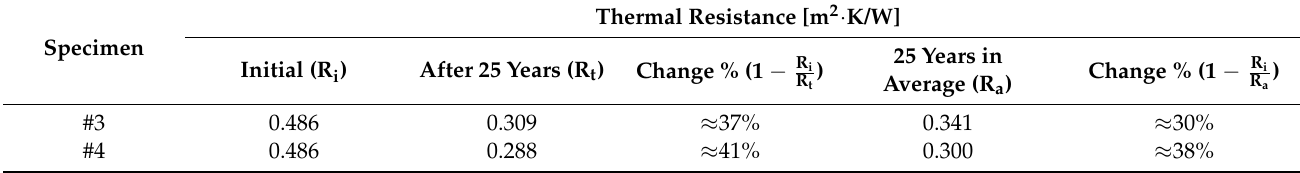
Table 4. Slice test results.